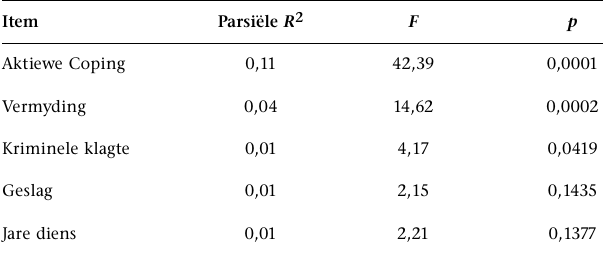
Tabel 5 dui aan dat oortydwerk die ernstigste stressor vir polisiebeamptes is. Verskeie ander stressors, wat deel uitmaak van ’n gebrek aan werkshulpbronne, is egter ernstig. Stres ontstaan veral as gevolg van personeeltekorte, ’n gebrek aan erkenning, ontoereikende salaris, swak gehalte toerusting en